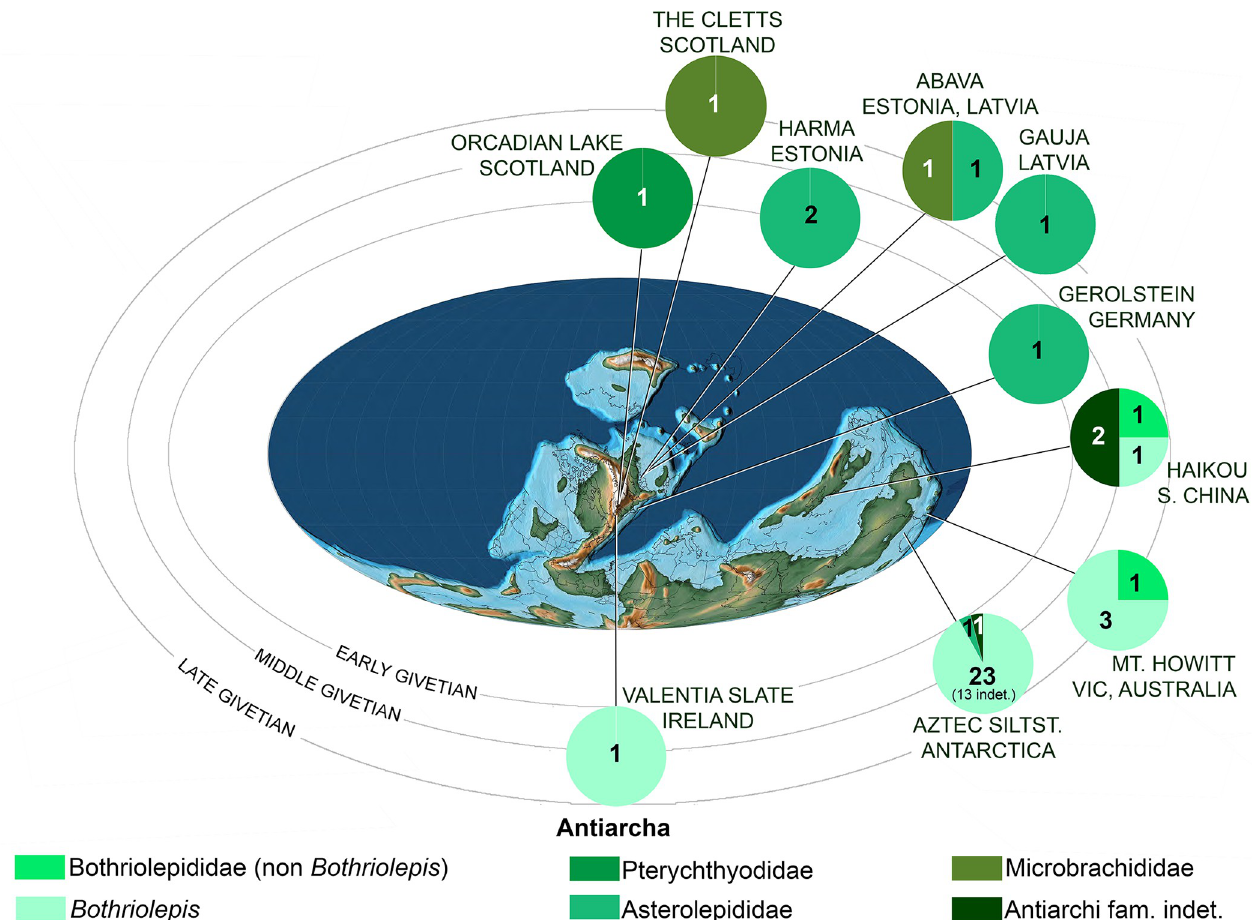
Fig 17. Distribution and composition of Givetian Antiarcha. Pies correspond to best known localities and associated updated taxa formerly listed in Sallan and Coates (96), with the addition of Valentia Slate formation; they are plotted on a palaeomap of the Givetian (modified after [38]; oceans in dark grey, shallow and epicontinental seas in light grey, emerged continents in white). Early Givetian localities have their pies closer to the edge of the map; late Givetian are furthest. NB. 13 unnamed and indeterminate species of Bothriolepis in Antarctica mentioned by Young [25] are taken in consideration in this figure.